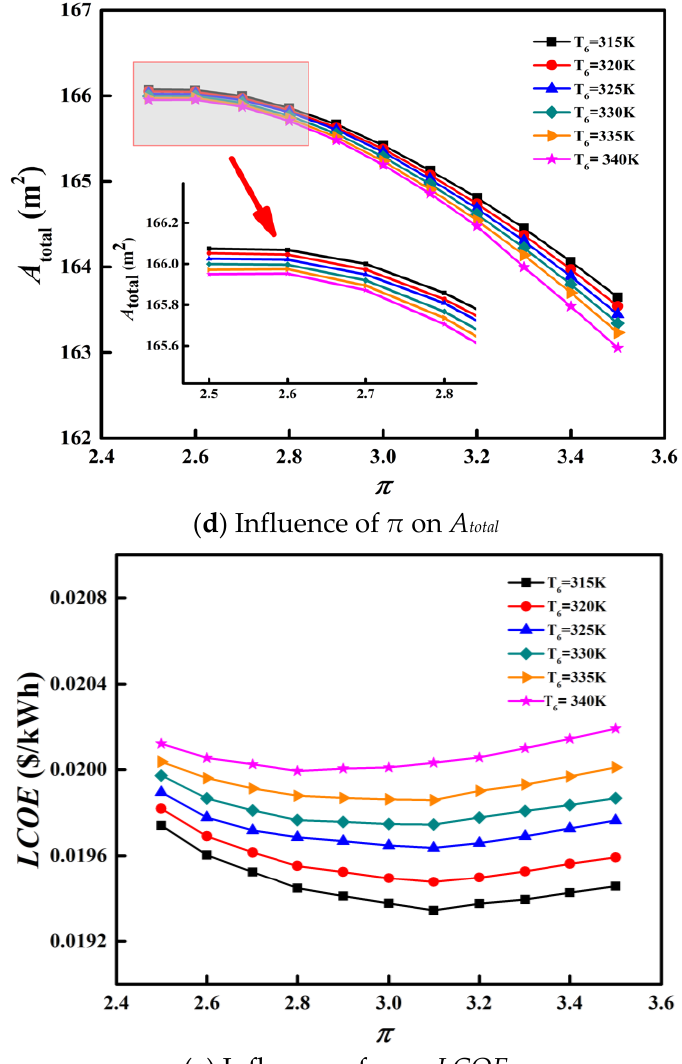
Figure 7. Influence of π on the proposed S-(N 2 O-He) cycle.